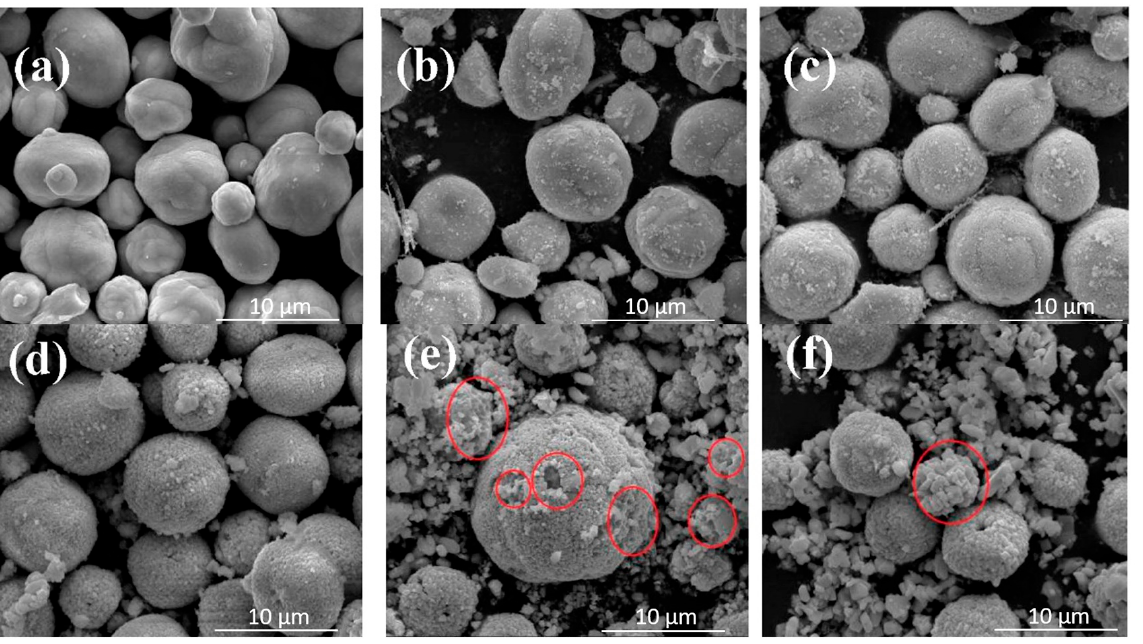
Figure 5. SEM maps of the BiVO 4 prepared at different hydrothermal times with an observation diameter of 10 μ m: ( a ) 0, ( b ) 3, ( c ) 6, ( d ) 12, ( e ) 14, ( f ) 24 h. Table 2. Related physical properties of the BiVO 4 crystals.